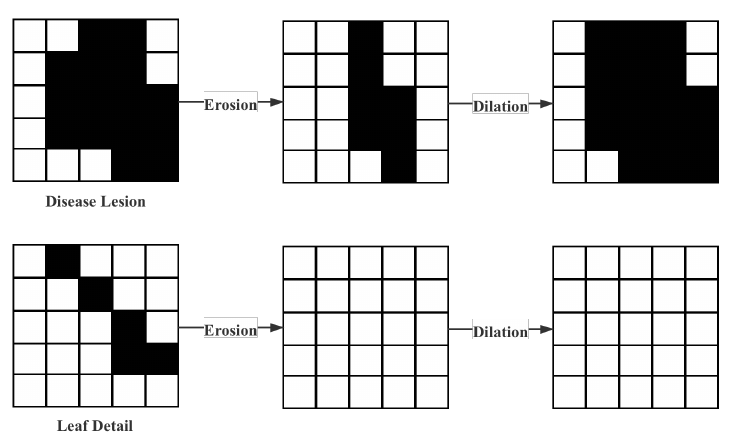
Figure 6. Processing of removal of interferential leaf